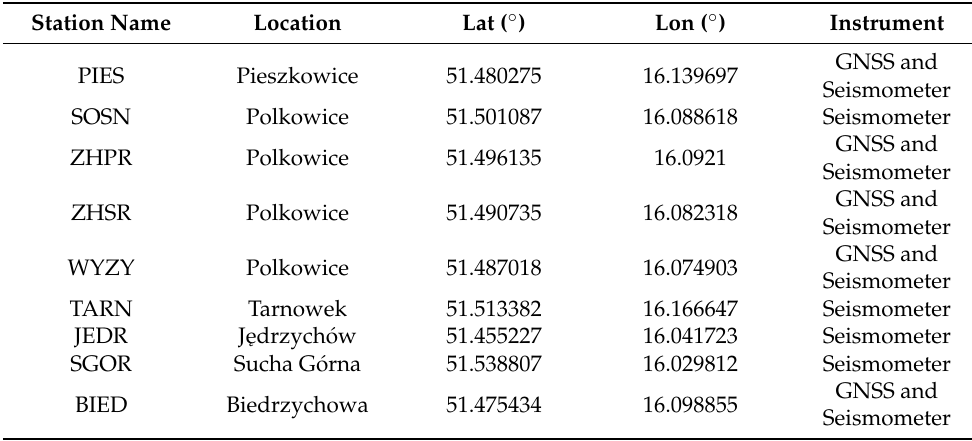
Table 2. Location of seismometers and GNSS stations.